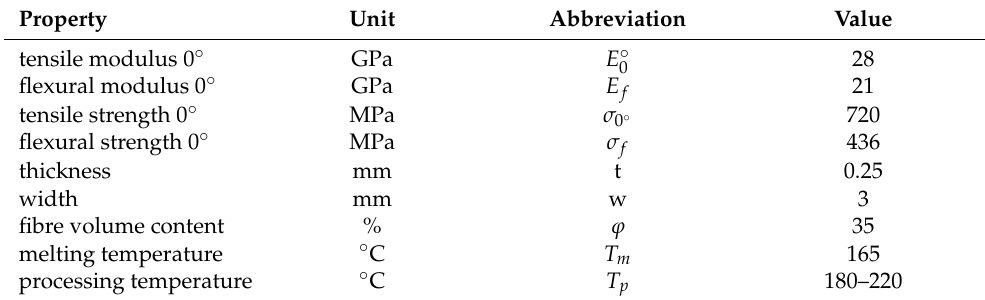
Table 1. Unidirectional PP GF 60 prepreg from BÜFA Thermoplastic Composites GmbH & Co. KG [35].